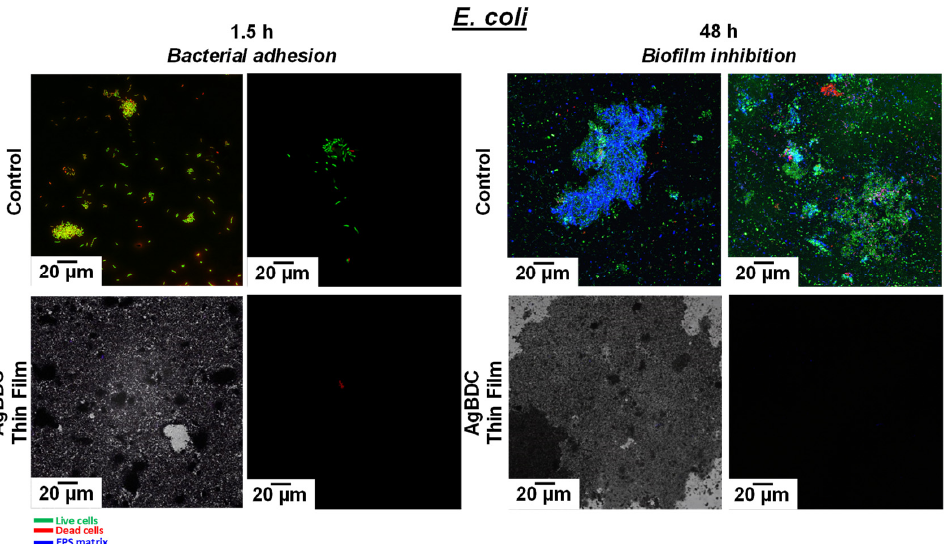
Figure 6. Fluorescence LIVE/DEAD confocal images of sessile E. coli biofilm (bottom right) and transmission mode (bottom left) on cover glass surface were taken after 1.5 h («bacterial adhesion») and 48 h («biofilm growth») of contact with AgBDC thin films (100 ppm; bottom). The MOF absence was used as control (top), highlighting with specific staining the bacterial viability (viable: green; dead: red) and the biofilm formation (blue). The scale bar corresponds to 20 µm. All the images were taken at 63×.